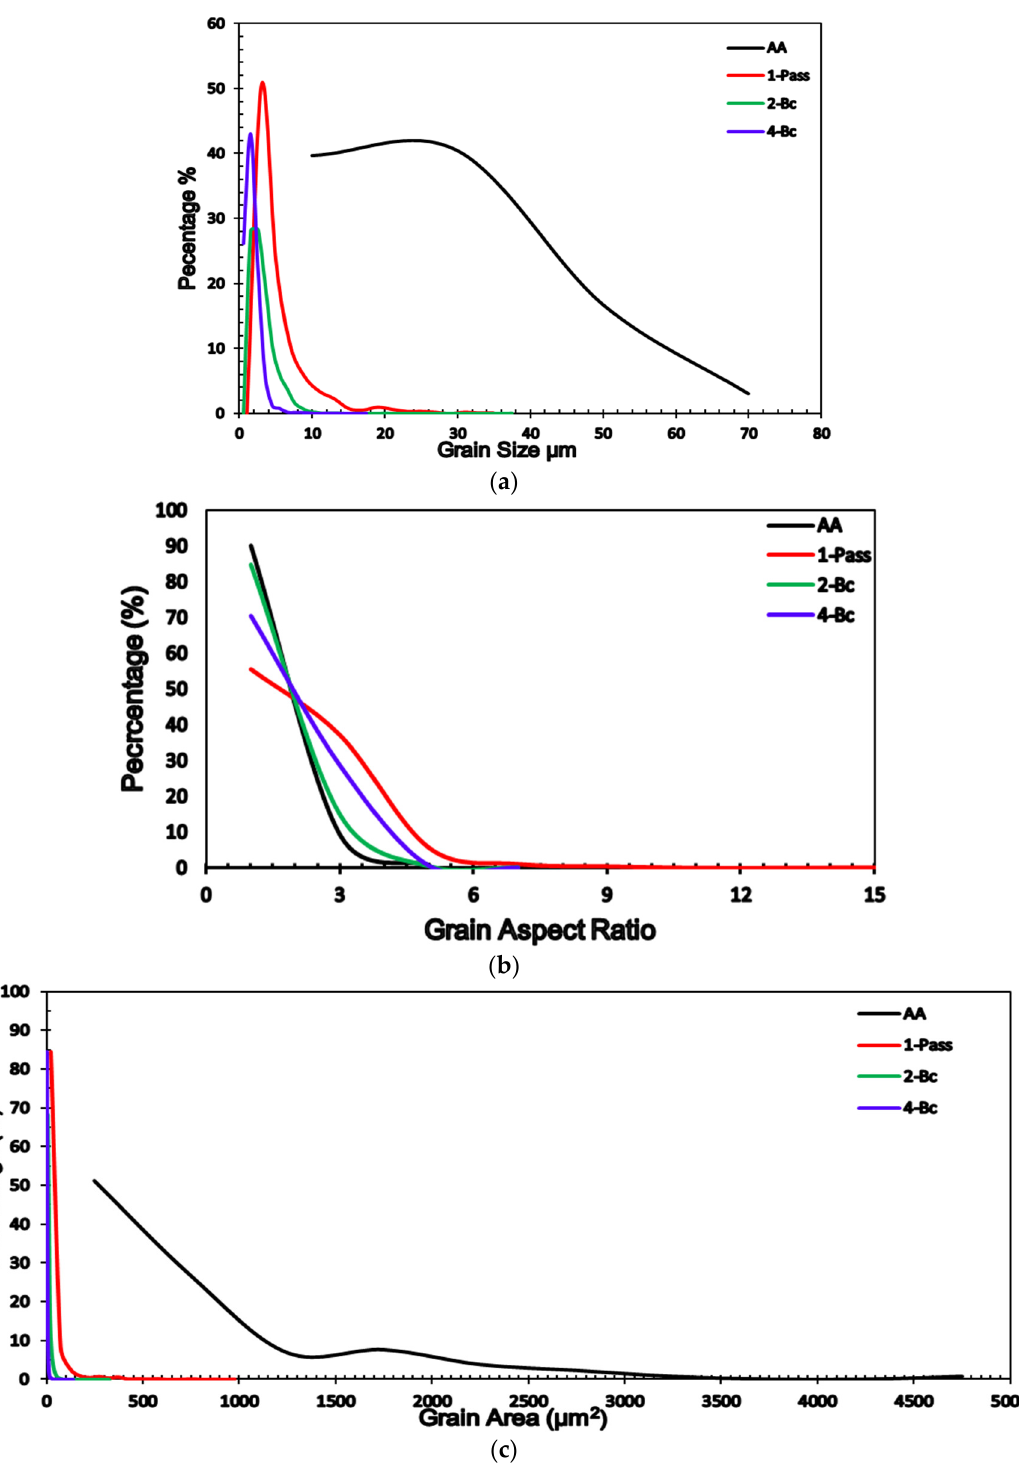
Figure 5. Relative frequency of ( a ) grain size, ( b ) grain aspect ratio, and ( c ) grain area distribution of the ZK30 alloy AA and ECAPed billets.